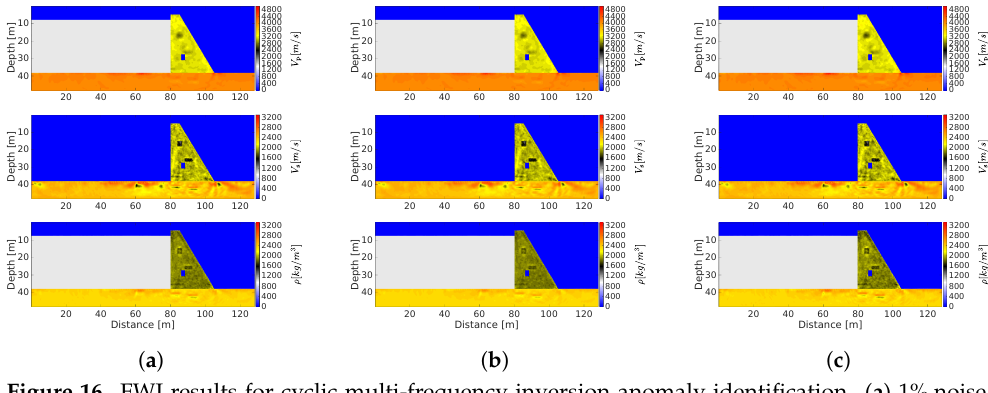
Figure 16. FWI results for cyclic multi-frequency inversion anomaly identification. ( a ) 1% noise; ( b ) 5% noise ( c ); 10% noise.